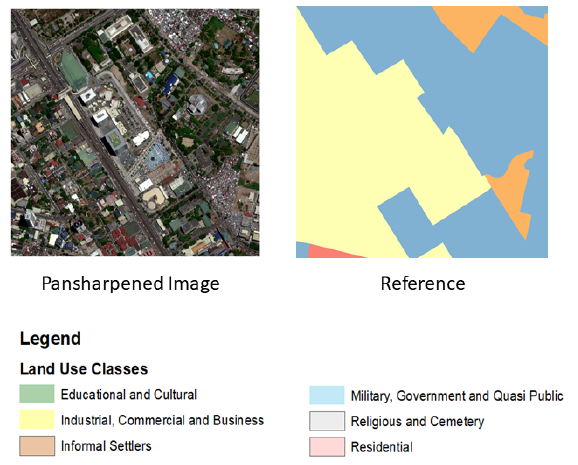
Figure 1. Sample image and corresponding reference for test Tile